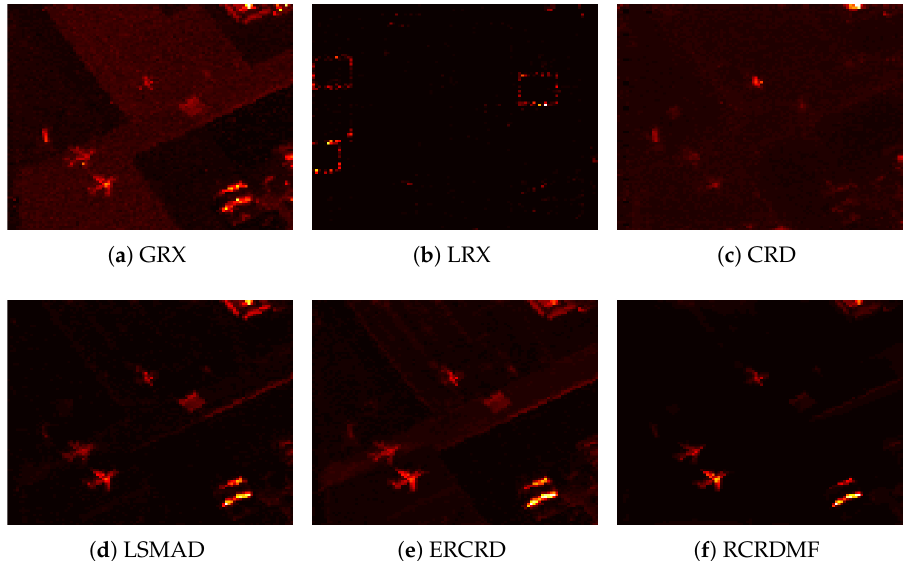
Figure 7. Color detection maps obtained by different algorithms for the AVIRIS-II dataset. ( a ) GRX,